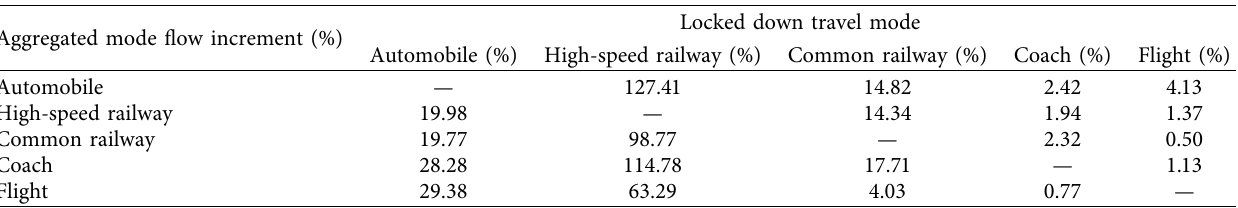
Table 15: Results of the aggregated mode flow increment in percentage under cases applying lockdown on different travel modes for destinations outside